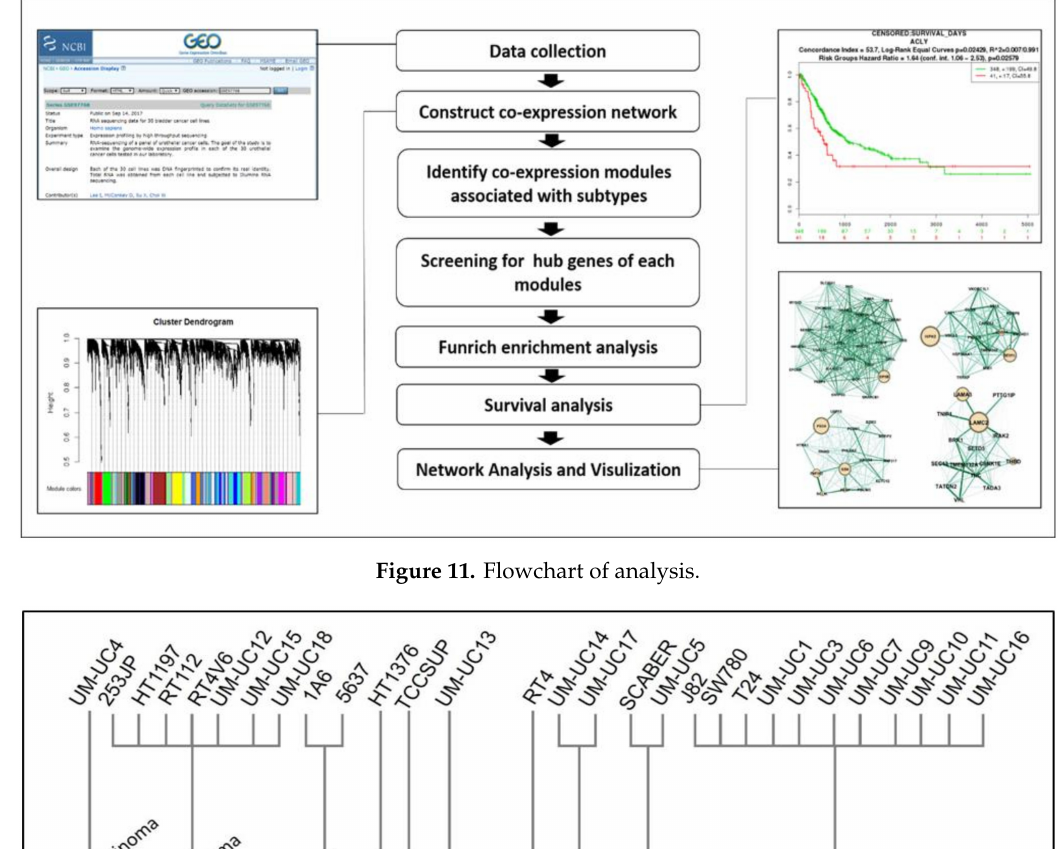
Figure 11. Flowchart of analysis.